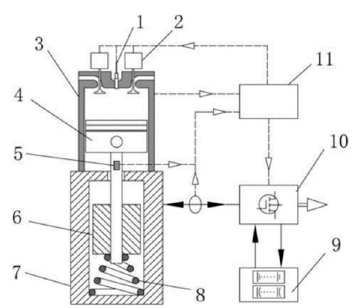
Figure 15. Basic structure of free-piston linear generator (FPLG) at Nanjing University of Science and Technology [7].